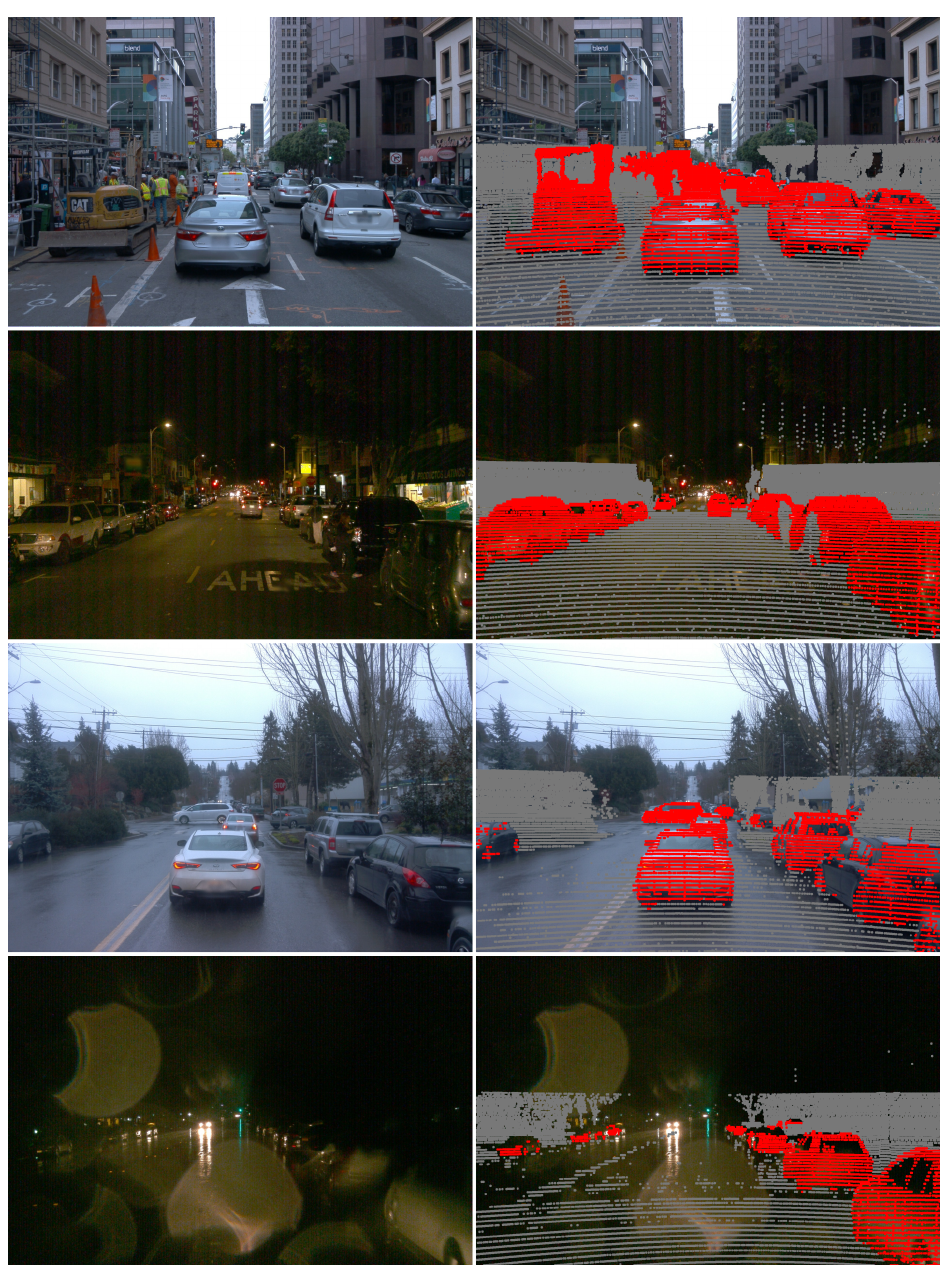
Figure 1. Some examples of driving scenes from the Waymo dataset. The left column shows four RGB images captured under various lighting and weather conditions, whereas the right column contains the corresponding semantic masks obtained using the procedure described in Section 3.3. Red pixels denote the vehicle class, while grey pixels denote the background (i.e., negative class). All other pixels in the semantic mask are ignored during